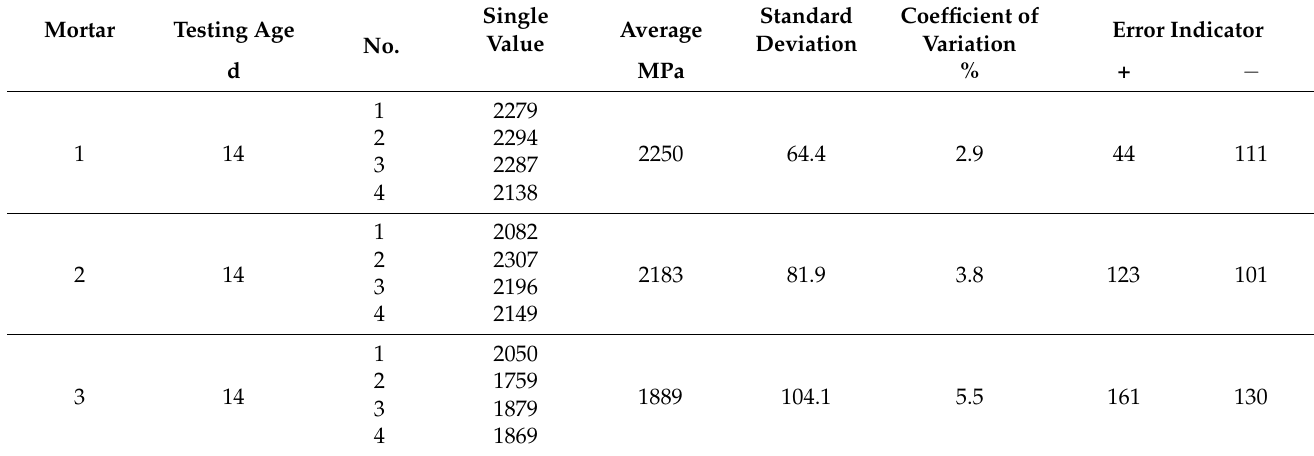
Table A6. Maximal uniaxial tension, carbon textile, Mortar 1–3.